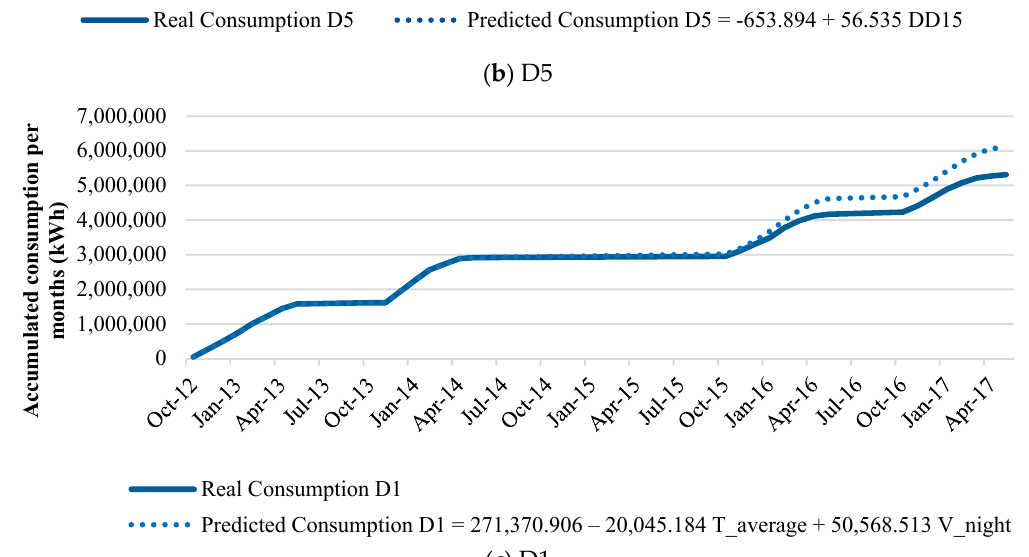
Figure 9. Graphs of real and predicted consumption. D3, D5 and D1 buildings. The differences found for each building and each of the facilities are shown in Tables 13 and 14. The differences that turned out to be statistically significant are shaded. The savings that appear as negative are the increases in consumption.